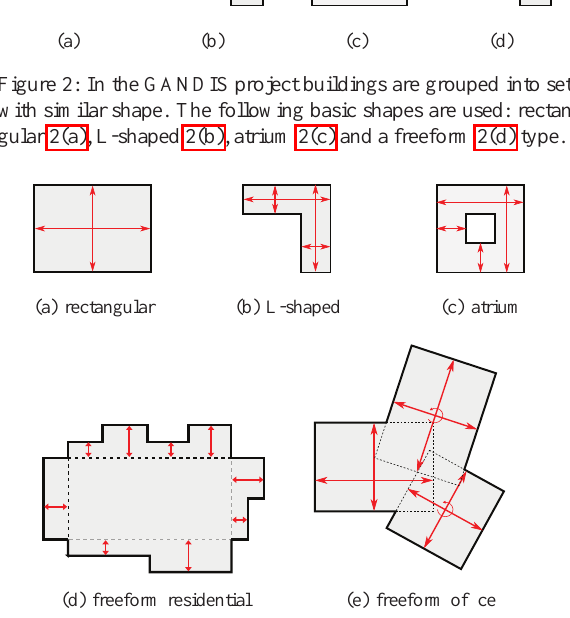
Figure 3: The first task was the definition of high level parame- ters (red) for each building